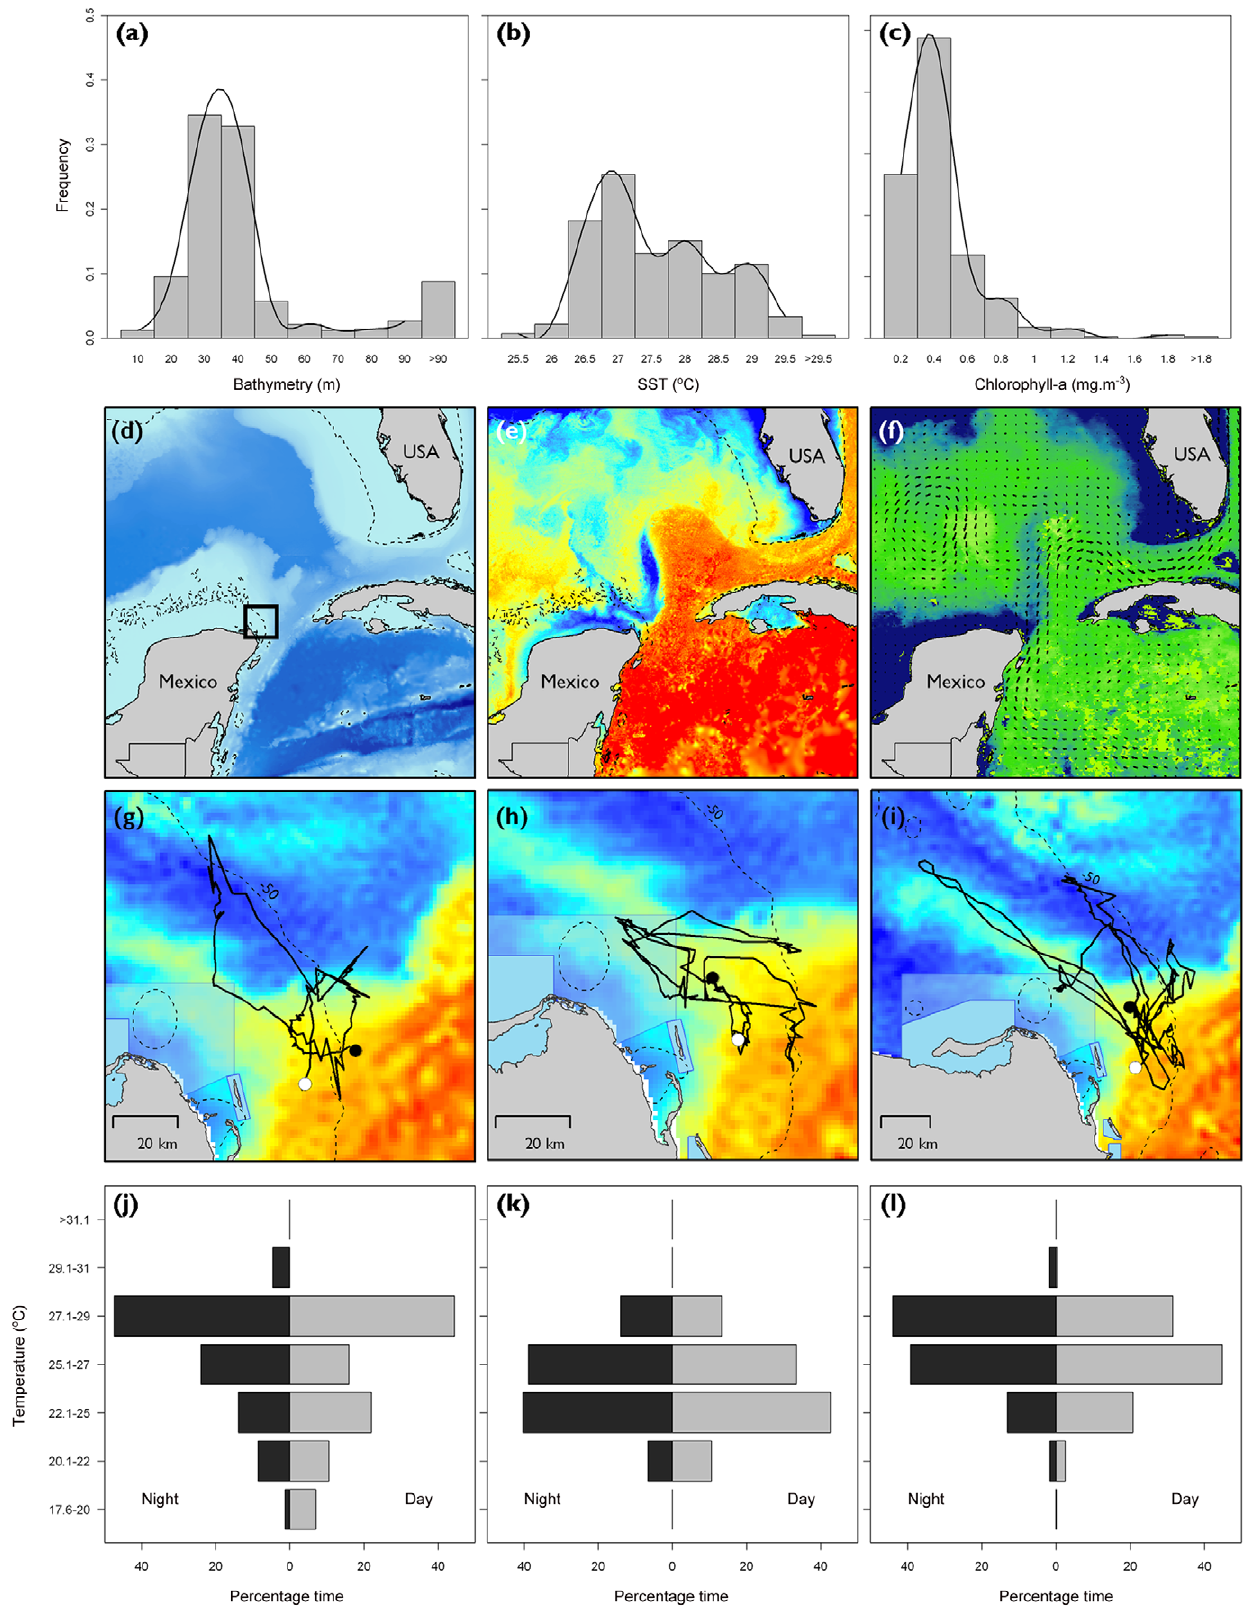
Figure 1. Movements of manta rays in the western Caribbean and south-east Gulf of Mexico. Frequency histograms of (a) bathymetry, (b) SST and (c) chlorophyll- a determined from the locations of all satellite tracked manta rays. Regional mapping of (d) bathymetry, (e) SST and (f)